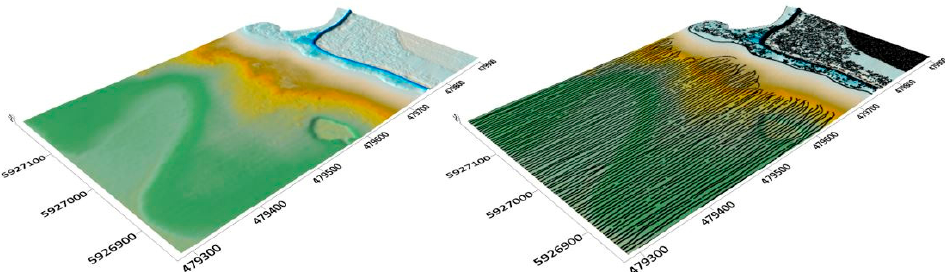
Figure 21. View of the combined model using the bilinear interpolation method. On the right, view with overlaid measurement data.